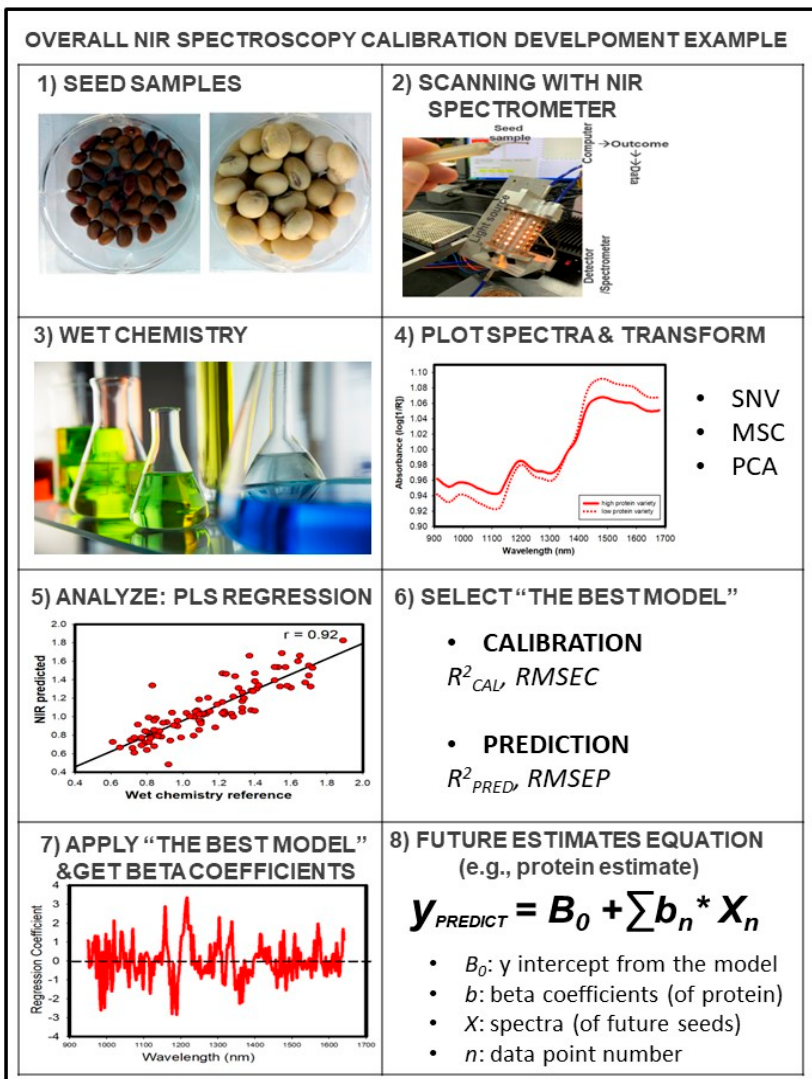
Figure 2. Overall calibration example for NIR Spectroscopy. After the completion of calibration and validation, calibration can be used to predict unknown seed samples for traits such as protein content. y PREDICT : prediction; B0 : the intercept from the model; b n : beta coefficients; X n : spectra of future seeds; n : data point number; RMSEC : root mean square error of calibration; RMSEP : root mean square error of prediction; SNV : standard normal variate; MSC : multiplicative scatter correction; PCA : principal component analysis (see Section 2.3 for more details).